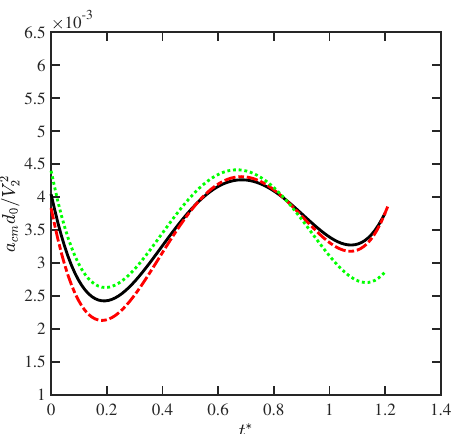
Figure 9. Time history of the normalized streamwise acceleration of the water column CM: CFD II (green dotted line), CFD III (black solid line), and reference numerical solution (red dashed-dotted